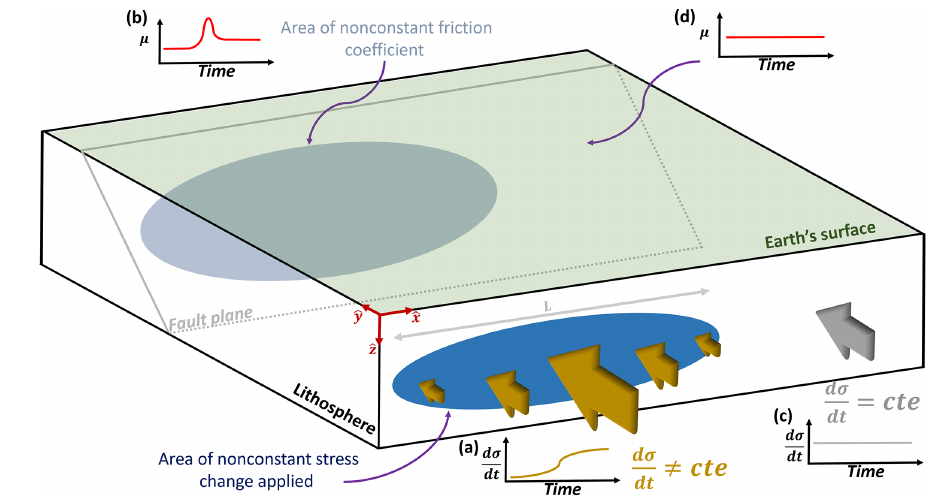
Figure 4. Schematic description of friction gradient on the fault. When a constant and nonconstant temporal stress change is applied at different places within the lithosphere, a nonzero friction coefficient gradient is